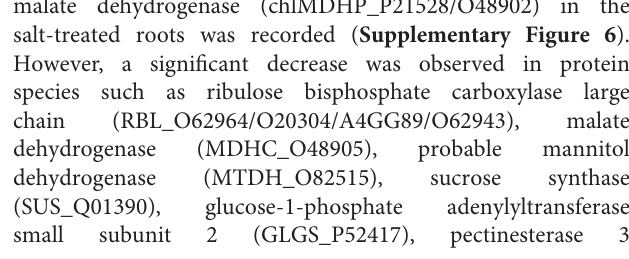
while β -amyrin synthase (BAMS_Q9LRH8) and soyasaponin III rhamnosyltransferase (SGT3_D4Q9Z5) were